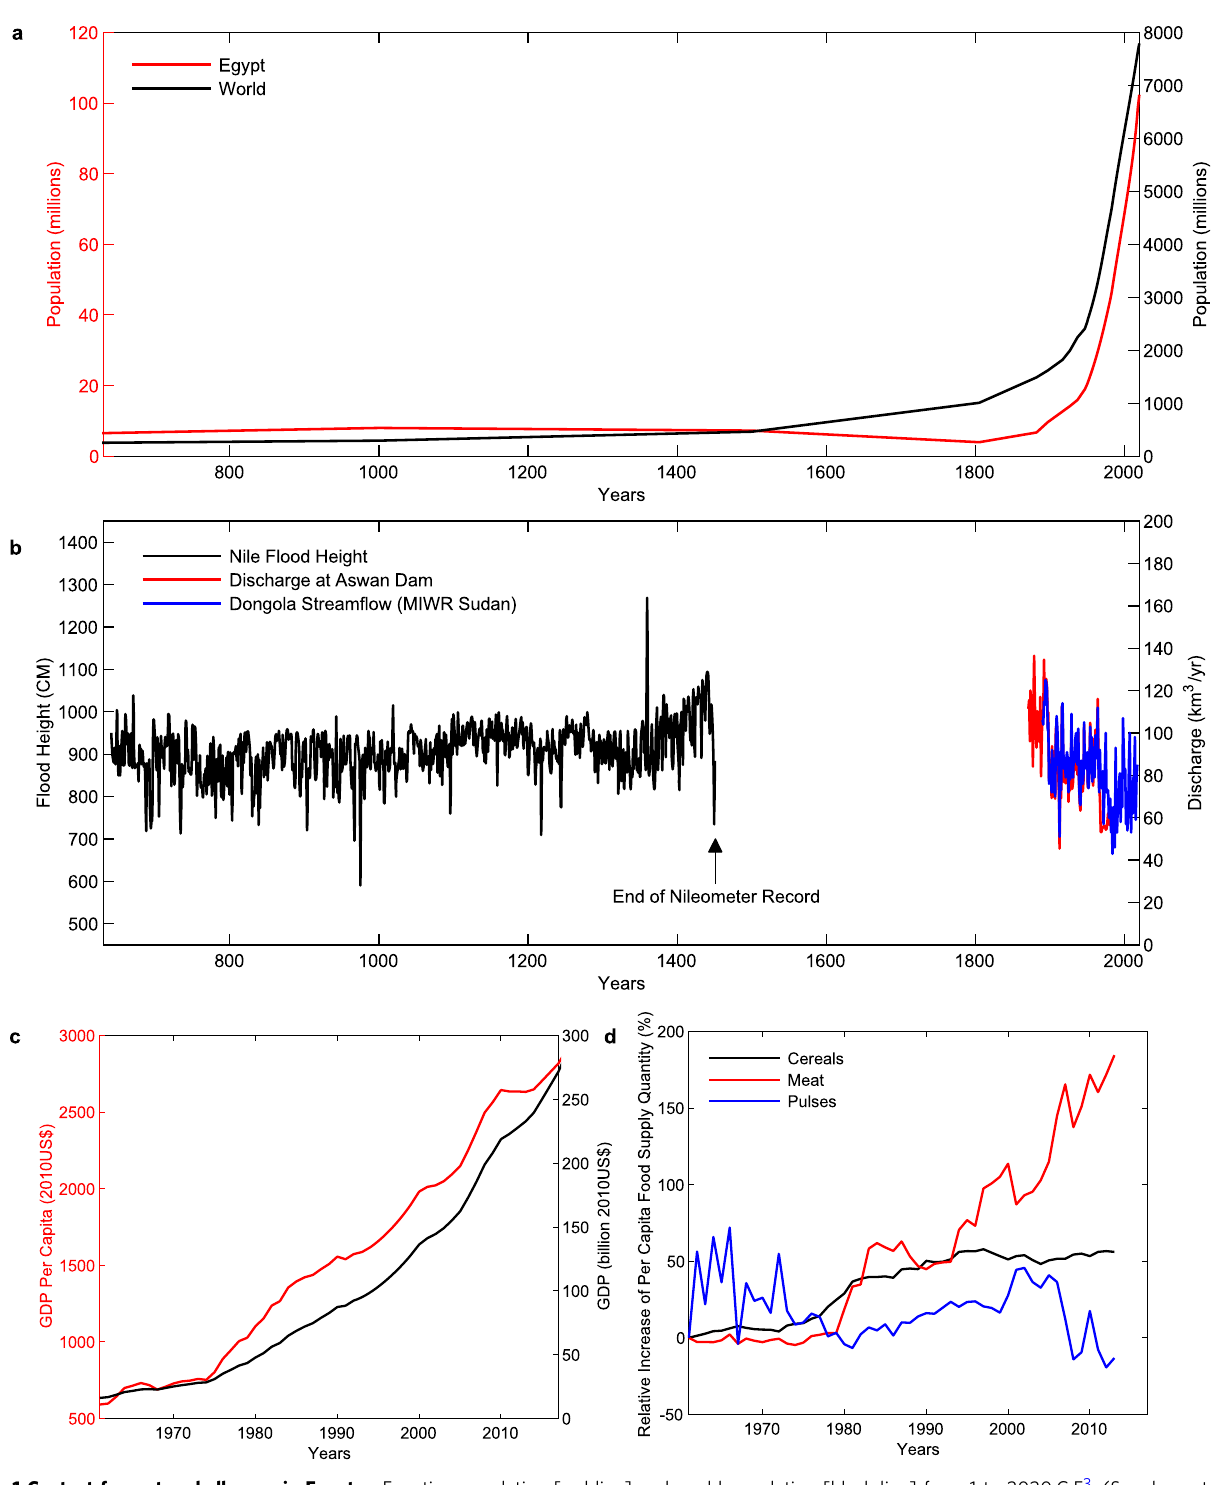
Fig. 1 Context for water challenges in Egypt. a Egyptian population [red line] and world population [black line] from 1 to 2020 C.E 3 . (Supplementary Table 1.4). b Qualitative comparison of stable Nile Flood heights from 641 to 1451 [black line – left axis] 13 and decreasing modern yearly average discharge from Aswan Dam [red line – right axis] and fl ow at Dongola [blue line – right axis] 16, 17 (Supplementary Tables 1.14 and 1.20). We note that the reader should not interpret a 1:1 correlation between the y-axes, and that the two separate groupings of data have been presented together to re fl ect that there has been little change in the Nile based on geologic survey 15 . c Gross Domestic Product (Constant 2010 $US) [black line] and GDP per Capita [red line] in Egypt 6 (Supplementary Table 1.6). d Relative change in per capita food supply (kg/capita/year) relative to 1961 for meat [red line], cereals [black line], and pulses (beans, chickpeas, lentils) [blue line]. 1961 values for meat, cereal, and pulses are 10.71, 161.43, and 6.5 kg/capita/yr respectively 7 (Supplementary Table 1.10).